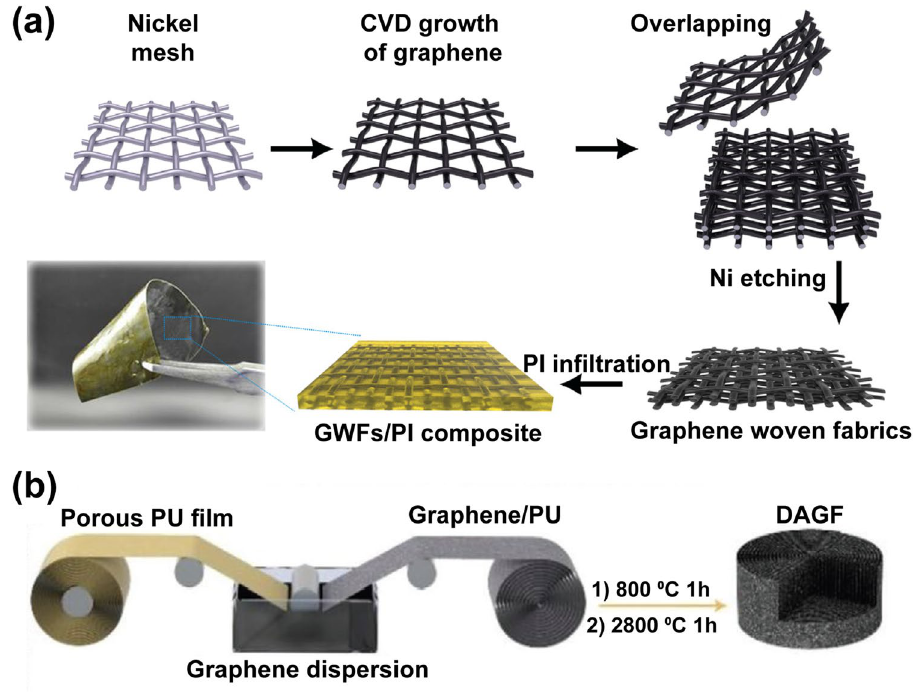
Fig. 15 The application of a compaction [116] and b rolling [115] processing in the fabrication of anisotropic graphene networks and their com‑ posites